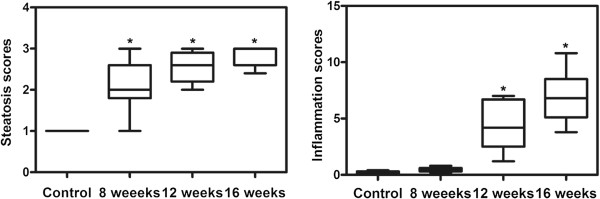
The steatosis scores and the inflammation scores of the liver in NAFLD rats. The steatosis scores and the inflammation scores were described in the “Methods” section. Data are medians (25/75th percentiles) for 9 rats per group. *P < 0.05 vs the control group.